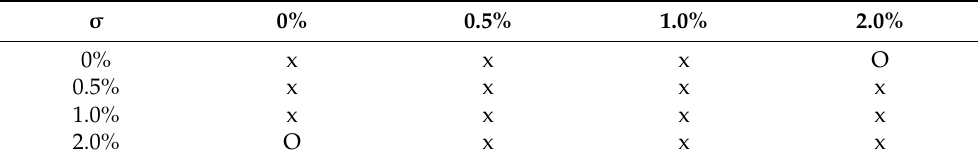
Table A6. Significant difference in dielectric constant between various Slacker concentrated groups. A significant difference was indicated with O and an insignificant difference was indicated with x.